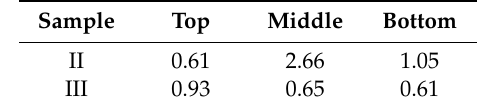
Table 4. Difference in the Al content in the range of 0.5 mm from the center line of sample II and III welds (wt.%).